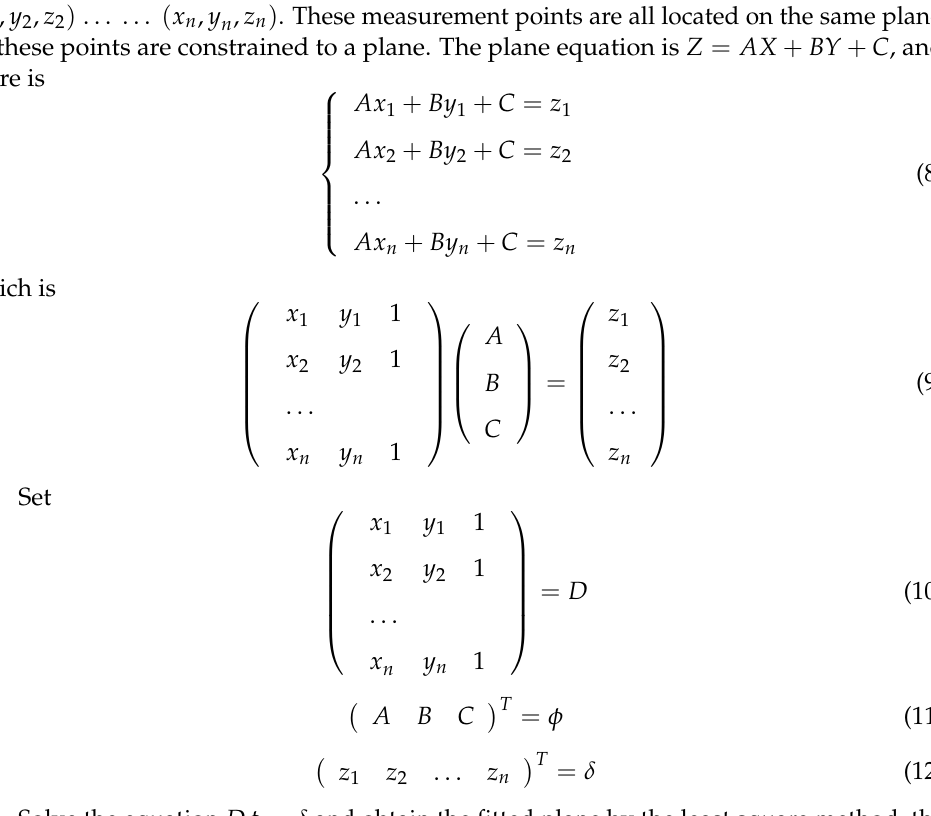
Figure 3. The calibration of self-rotating, LSL scanning, 3D reconstruction system based on plane constraints.